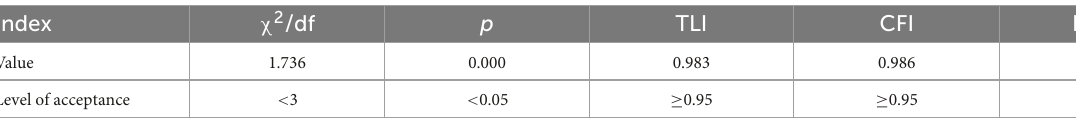
TABLE 3 Measurement model.